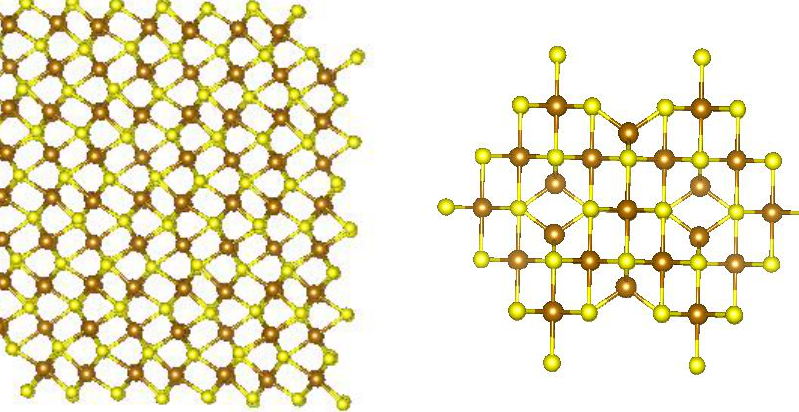
Figure 3. Crystal structures of Fe 3 S 4 , Fe 7 S 8 , and CuS.